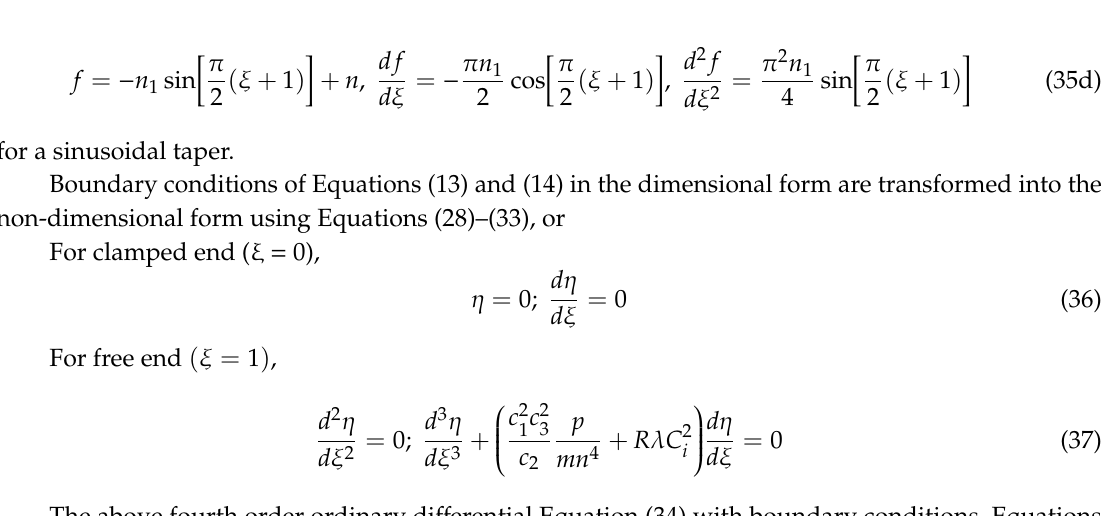
Table 1. Assumed initial conditions* at clamped end ( ξ = 0 ) and obtained trials at free end ( ξ = 1 ) . Clamped end ( ξ = 0 ) Set